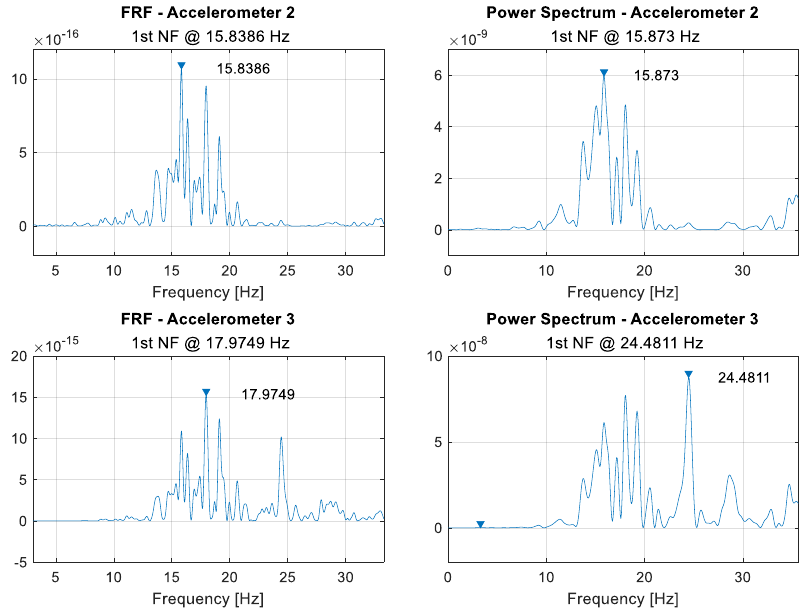
Figure A13. Arduino measurement: 4.0 revolution bolt release.